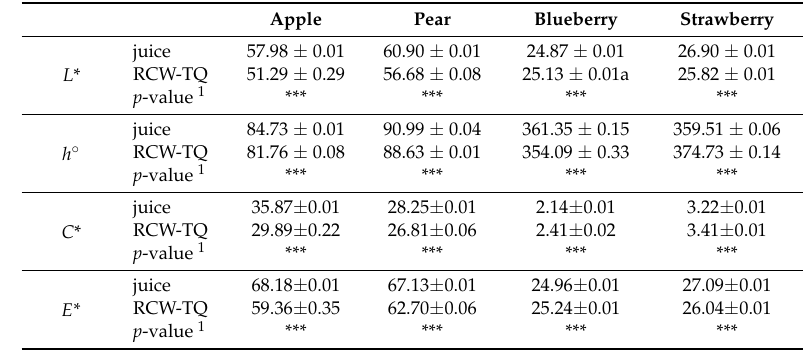
Table 4. Color parameters ( L *, lightness; h ◦ , hue angle (degrees); C *, chroma; E *, color index)